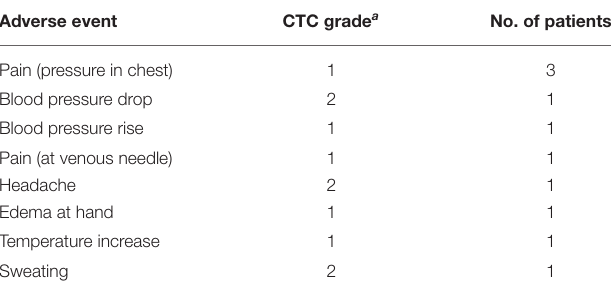
TABLE 2 | Overview of reported adverse events during apheresis treatments.